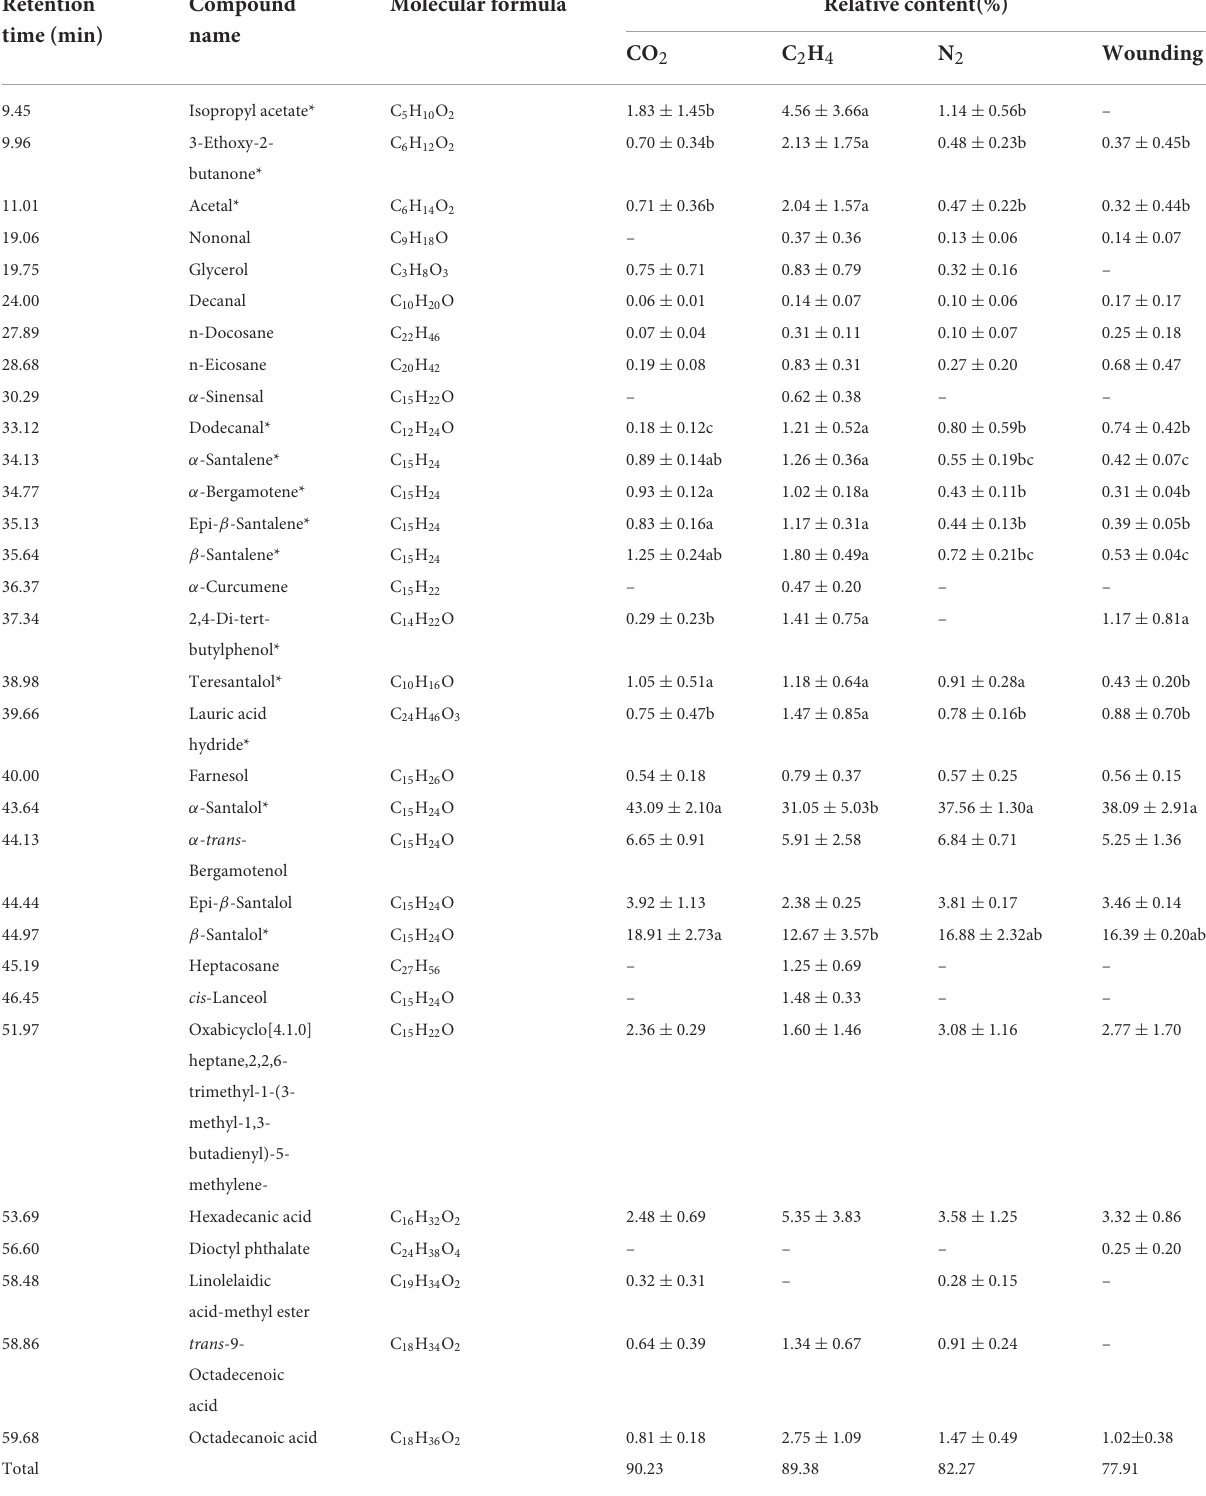
TABLE 2 Chemical composition of essential oil extracted from heartwood induced by differnet gas